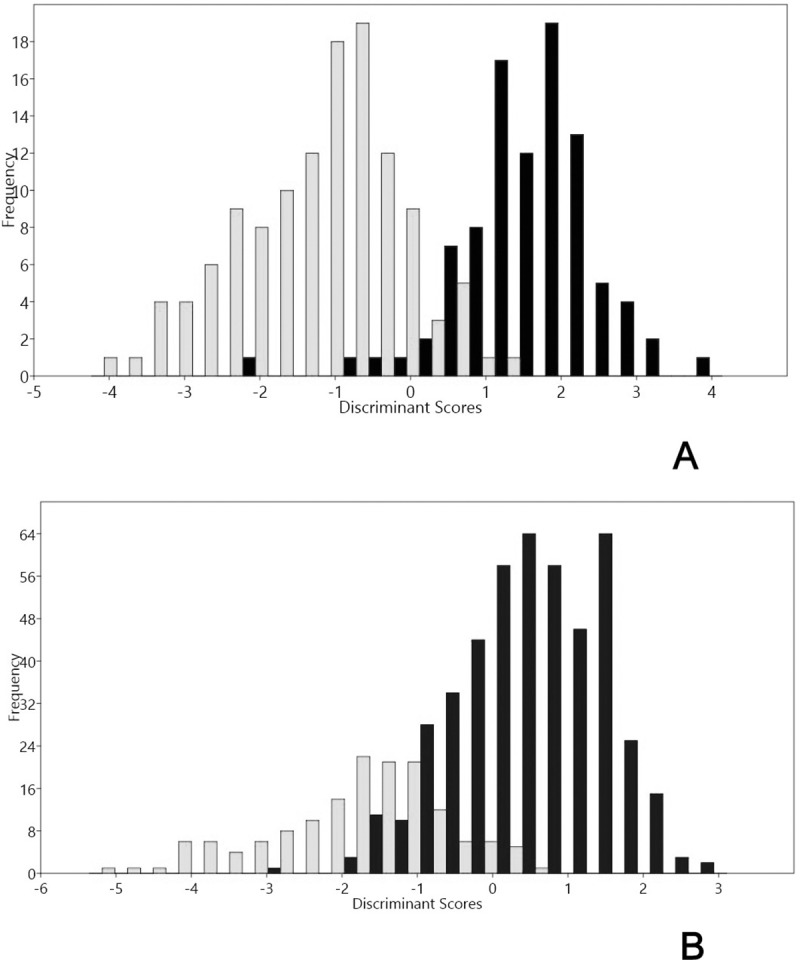
A) Histogram of discriminant scores for 10 traits in cobs and, B) five traits in kernels. Light bars show archaeological cobs and kernels; black bars show modern cobs and kernels. Two separated groups are present: modern and archaeological cobs and kernels.